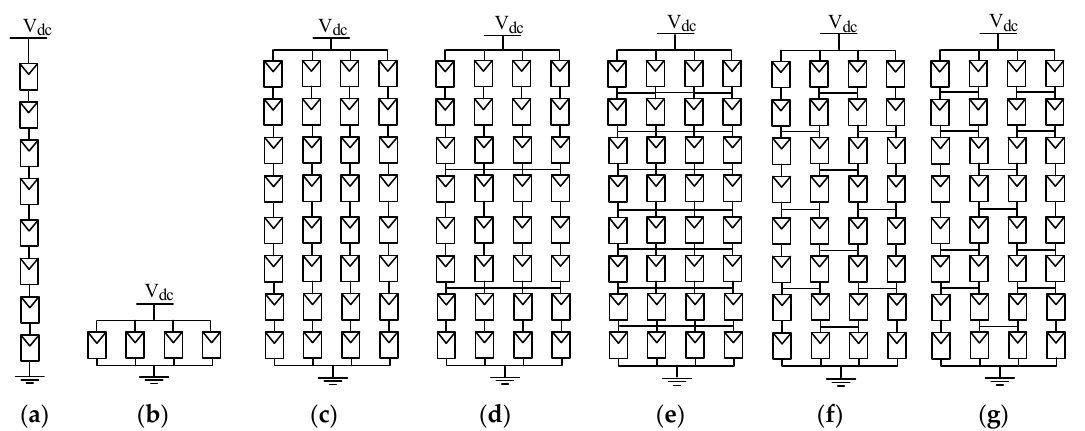
Figure 1. Common configurations of PV arrays: Series ( a ); Parallel ( b ); Series–Parallel ( c ); Series–Parallel–Series ( d ); Total-Cross-Tied ( e ); Bridge-Linked ( f ); Honey-Comb ( g ).